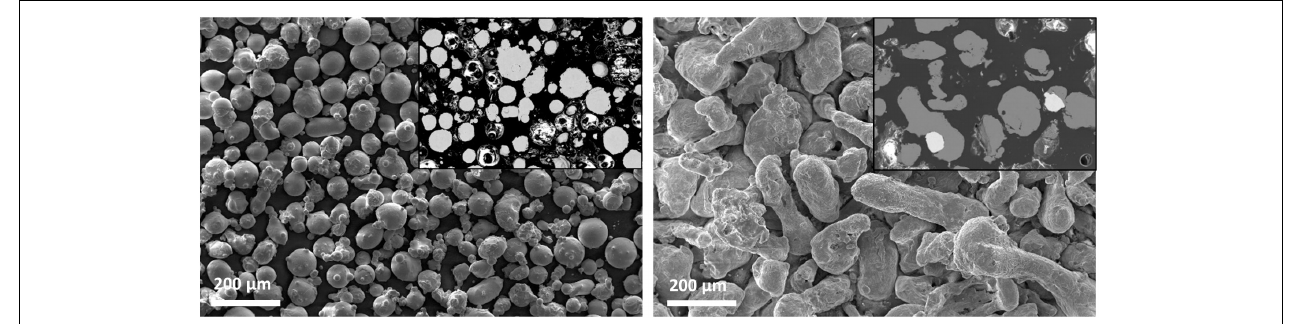
TABLE 2 | Chemical composition (EDS measurements) of the used powders in at%. Co Cr Fe Ni CoCrFeNi 25.2 26.1 25.4 23.3 Al O Al 98.8 1.2